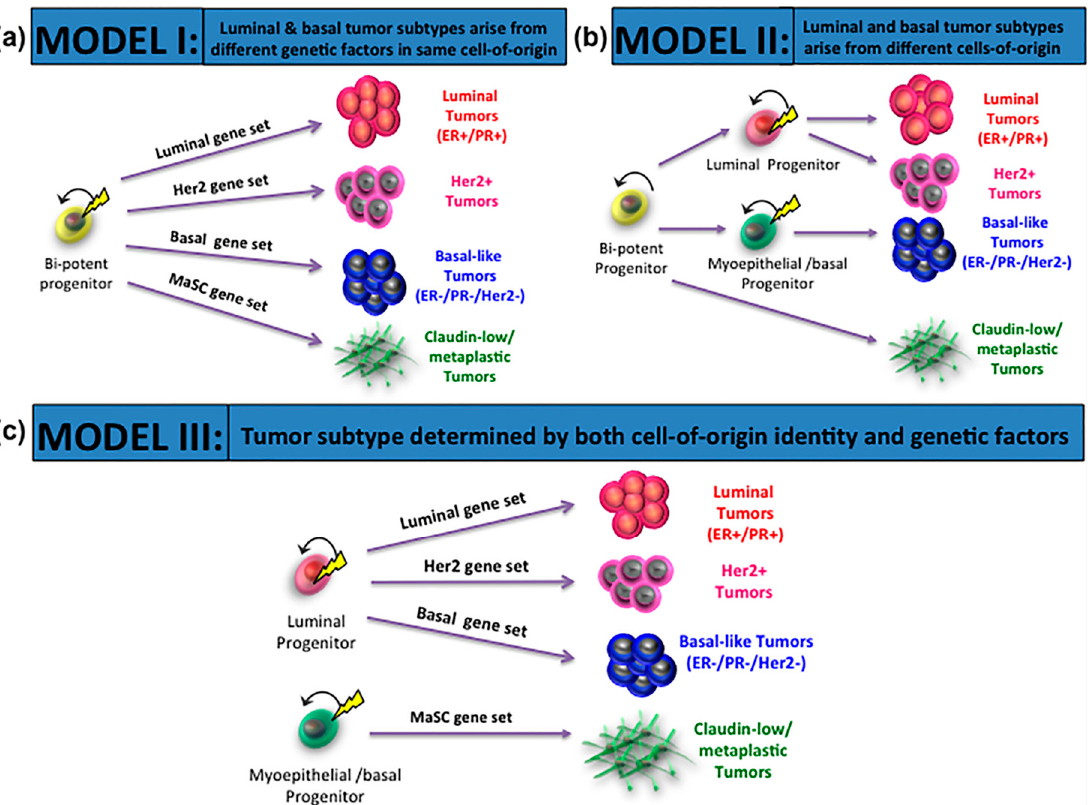
Figure 1. Schematic models of origins of breast cancer heterogeneity ( a ) Model I posits that mutations associated with neoplastic transformation determine subtype. ( b ) Model II posits that the cell-of-origin identity determines subtype during neoplastic transformation. ( c ) Model III posits that both mutation-of-origin and cell-of-origin contribute to the path of disease progression in regards to subtype development.